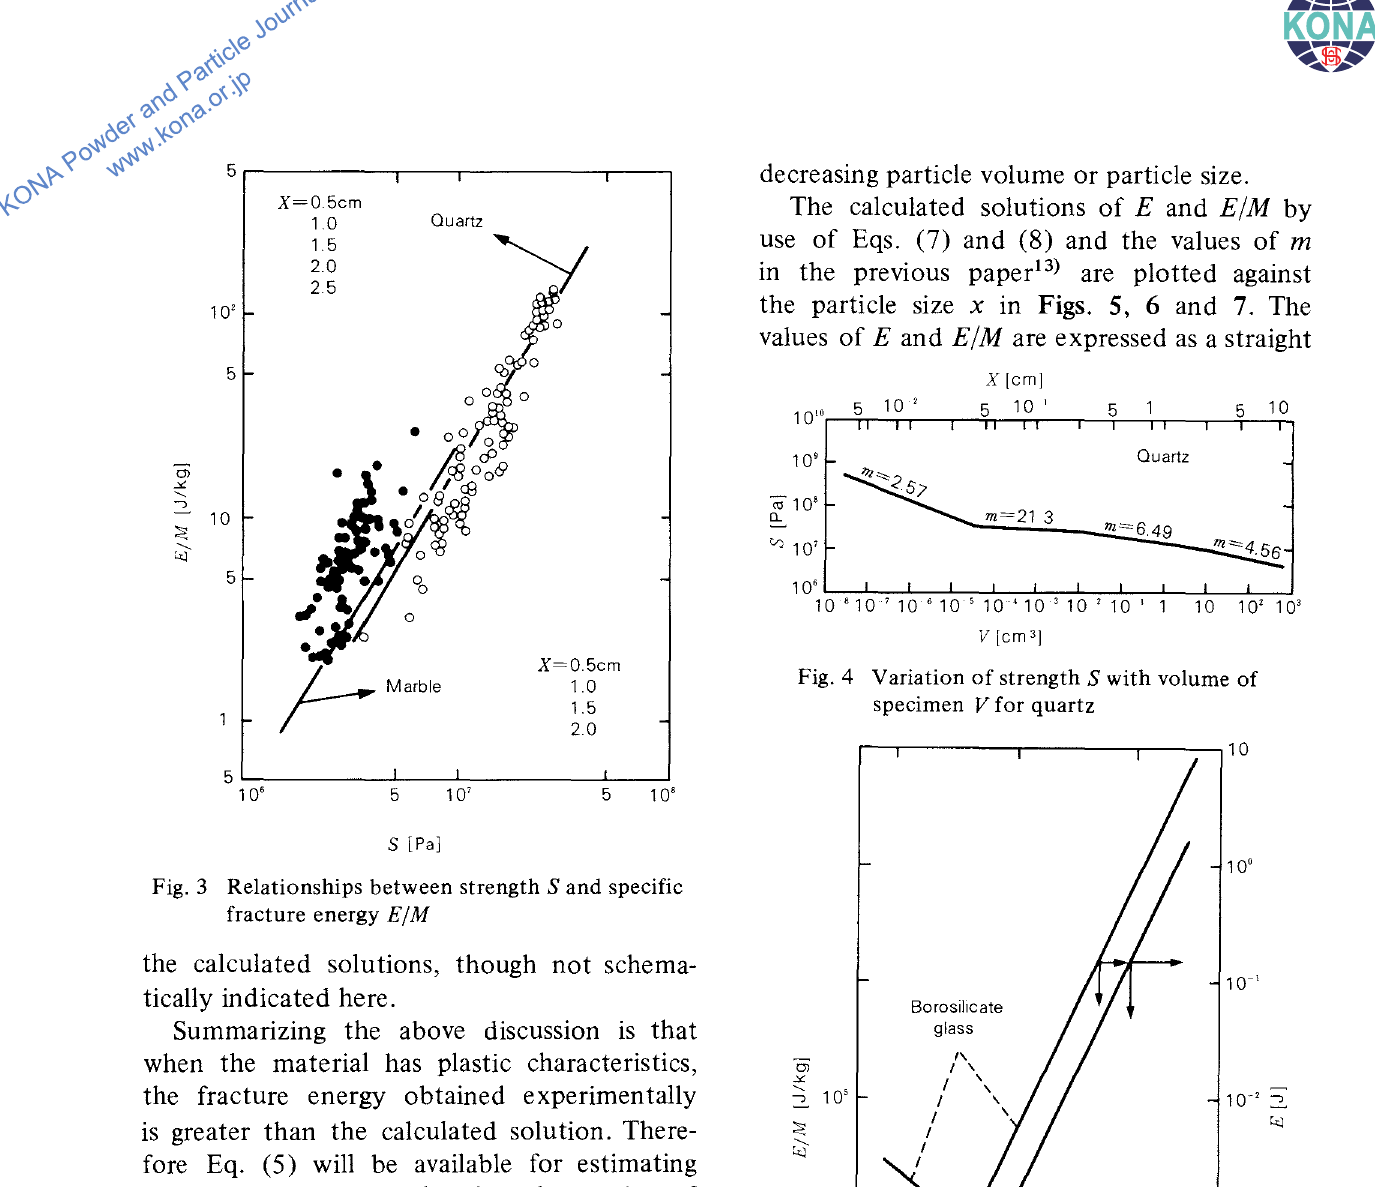
Fig. 4 Variation of strengthS with volume of specimen V for quartz